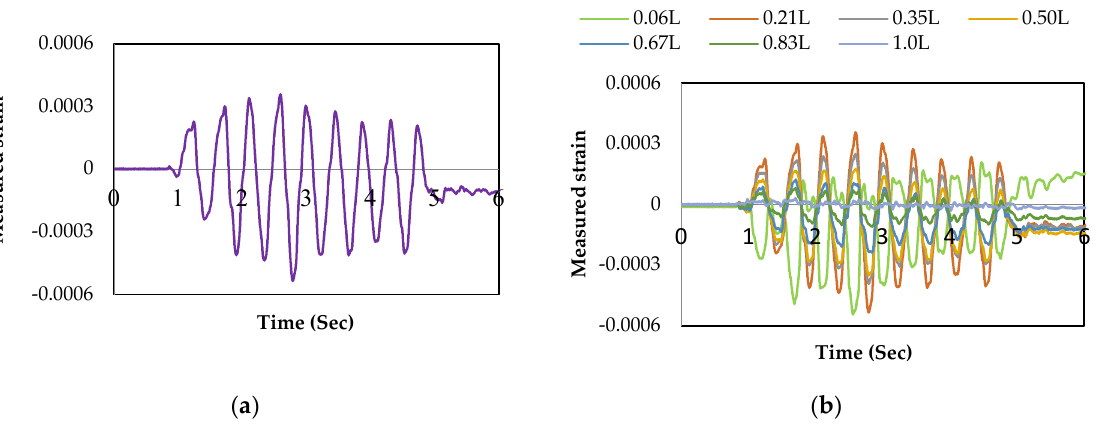
Figure 10. Typical strain measurements in the pile: ( a ) at the level of 0.21 L from the top ( L = 60 D and S = 3 D ), and ( b ) at all levels for the model, where L = 60 D and S = 3 D.